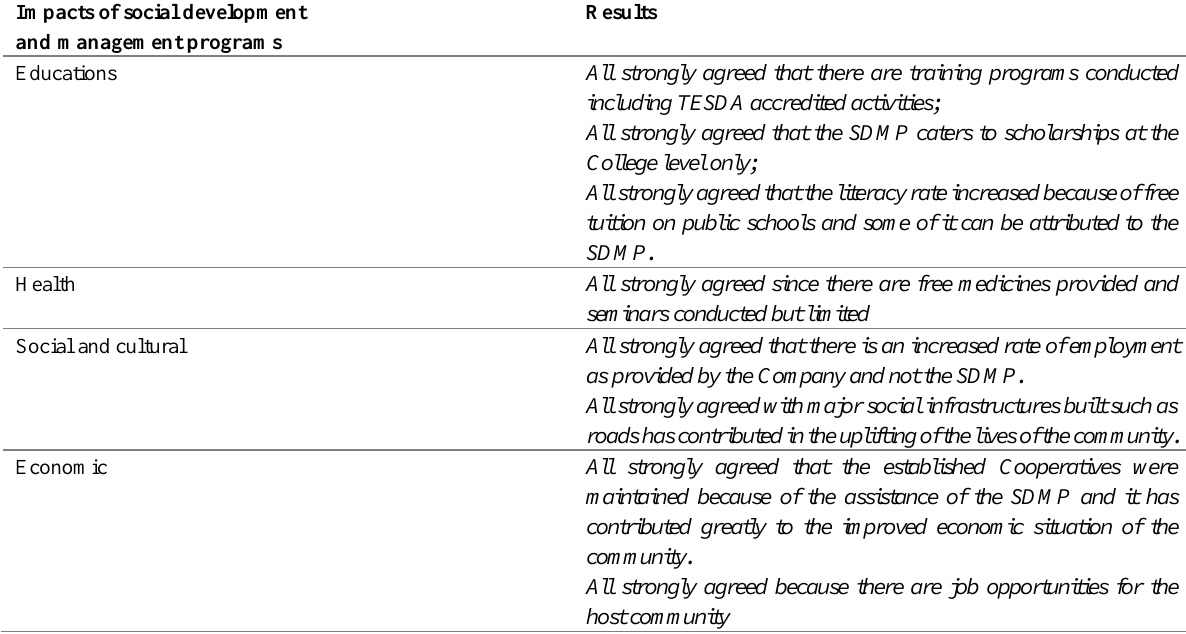
Table 3: Level of agreement of the respondents of the Barangay on the impact of SDMP